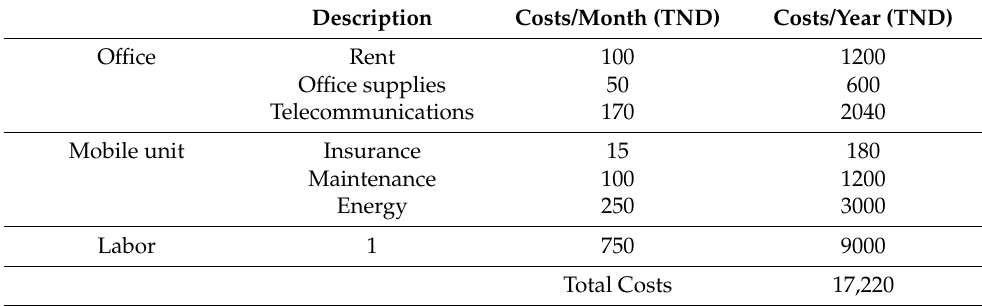
Table 7. Operating and labor